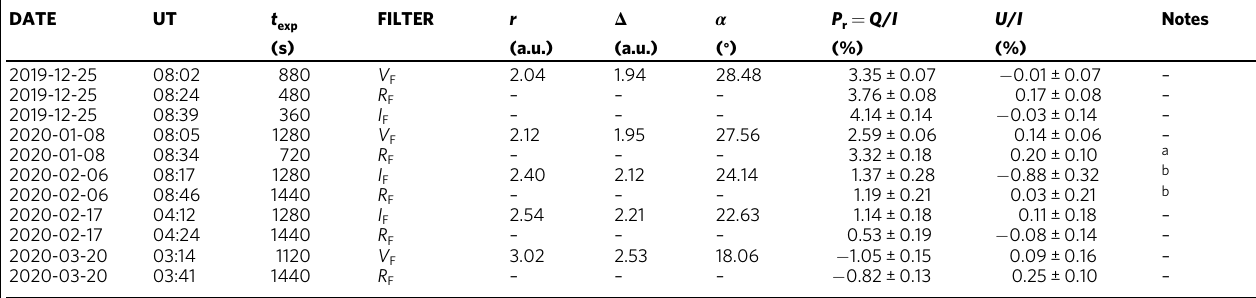
Tableisorganisedasfollows:observingdateandtime(cols.1and2);exposuretime(col.3);the fi lterusedfortheobservations(col.4);theheliocentricdistance r andgeocentricdistance Δ tothecomet (cols. 5 and 6, respectively); the phase angle (col. 7); the reduced Stokes parameters Q / I and U / I (cols. 8 and 9). Column 10 refers to special table footnotes. Effective wavelength and bandwidths as follow: fi lter V F is centred at 557nm with a 123-nm FWHM; fi lter R F is centred at 655nm with a 165-nm FWHM; fi lter I F is centred at 768nm with a 138-nm FWHM.